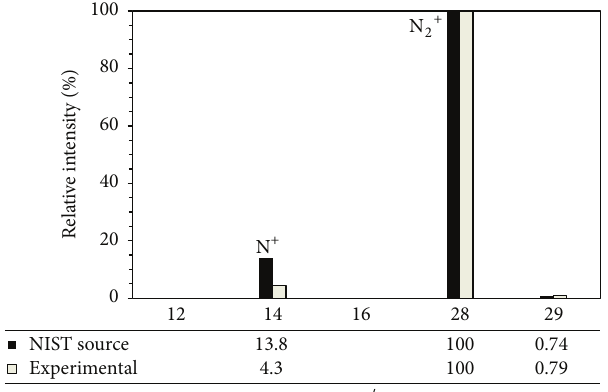
Figure 5: Pure N 2 mass spectrum obtained experimentally and its relative ion intensities. Reference values from NIST Chemistry WebBook [18] are shown for